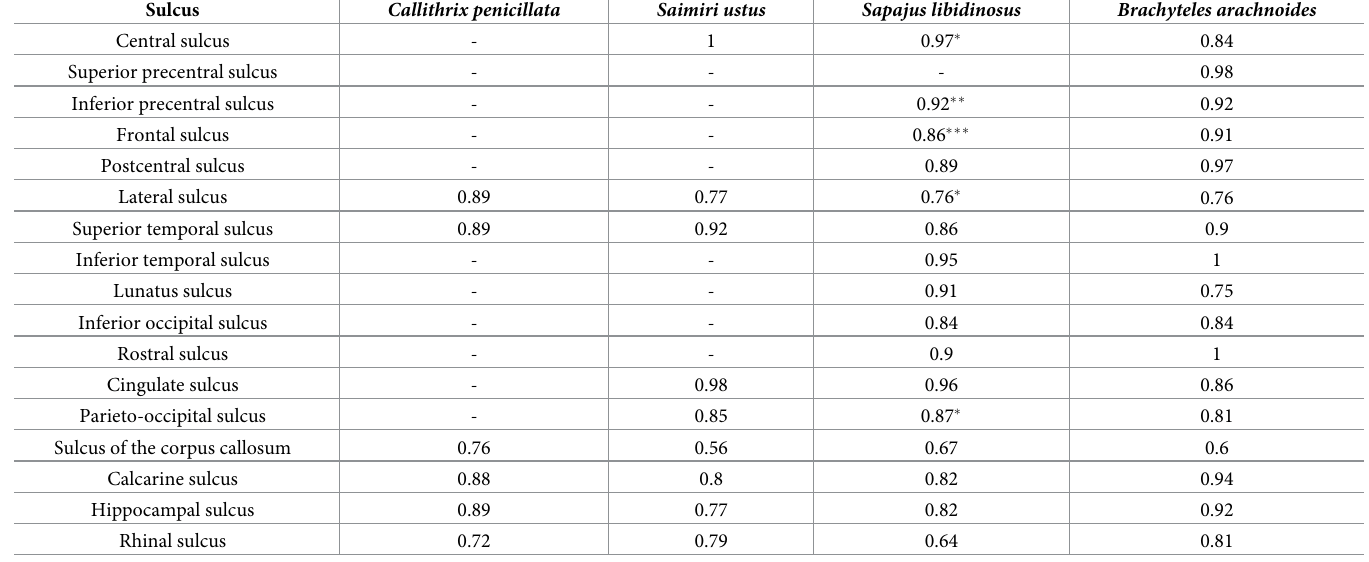
Table 6. Degree of sinuosity of the main sulci of primate species used in the present